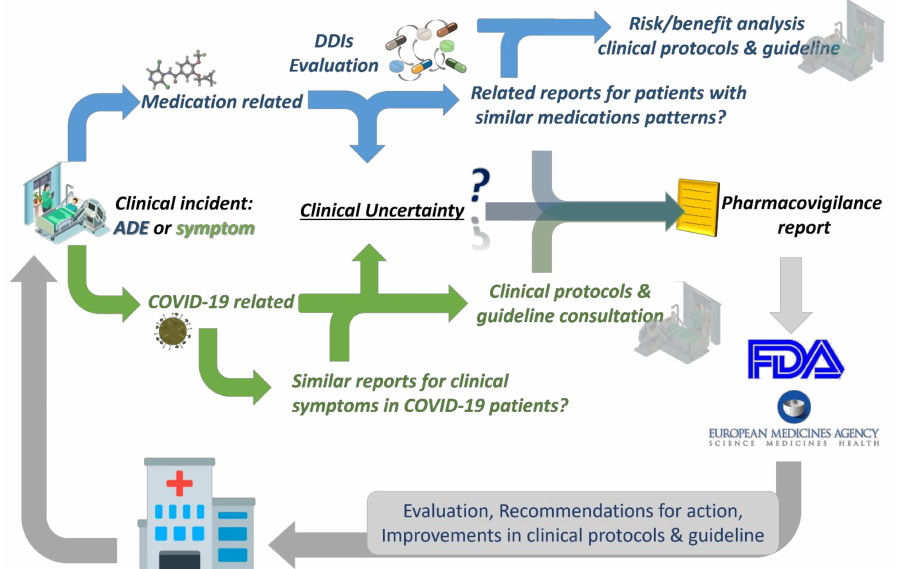
Figure 3. The importance of appropriate management of symptoms or ADEs for a COVID-19 patient and how healthcare professionals can actively participate in the analysis of different clinical scenarios, so regulatory can provide relative feedbacks improving clinical